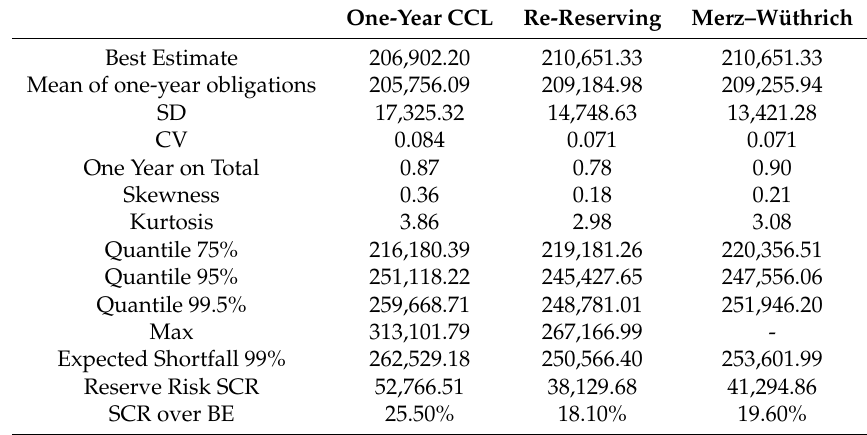
Table 6. We provide all the main results obtained applying three alternative one-year models to our triangle. Figures in italics regarding the Merz–Wüthrich formula have been produced by assuming a log-normal distribution for the claims reserve fitted on the BE and the σ M − W usp would have allowed to use as undertaking specific parameter . Amounts in thousands of